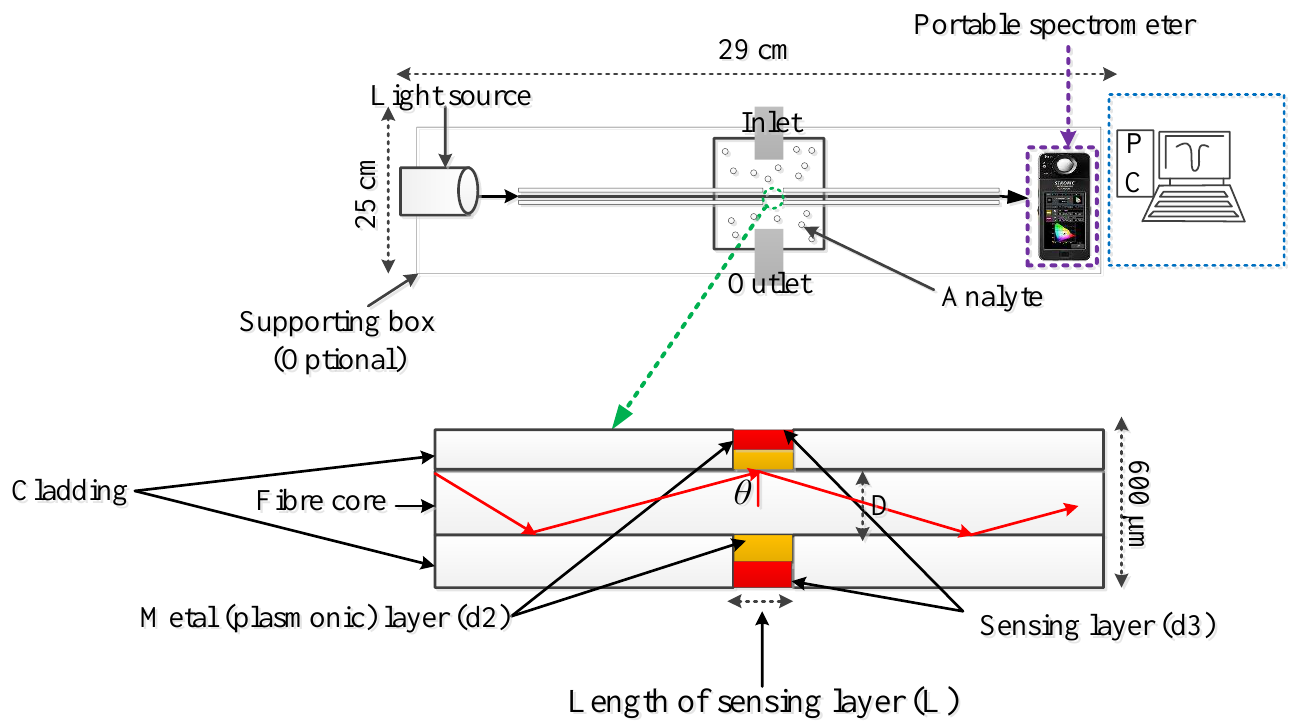
Figure 4. The schematic diagram of a typical portable FO SPR sensor.